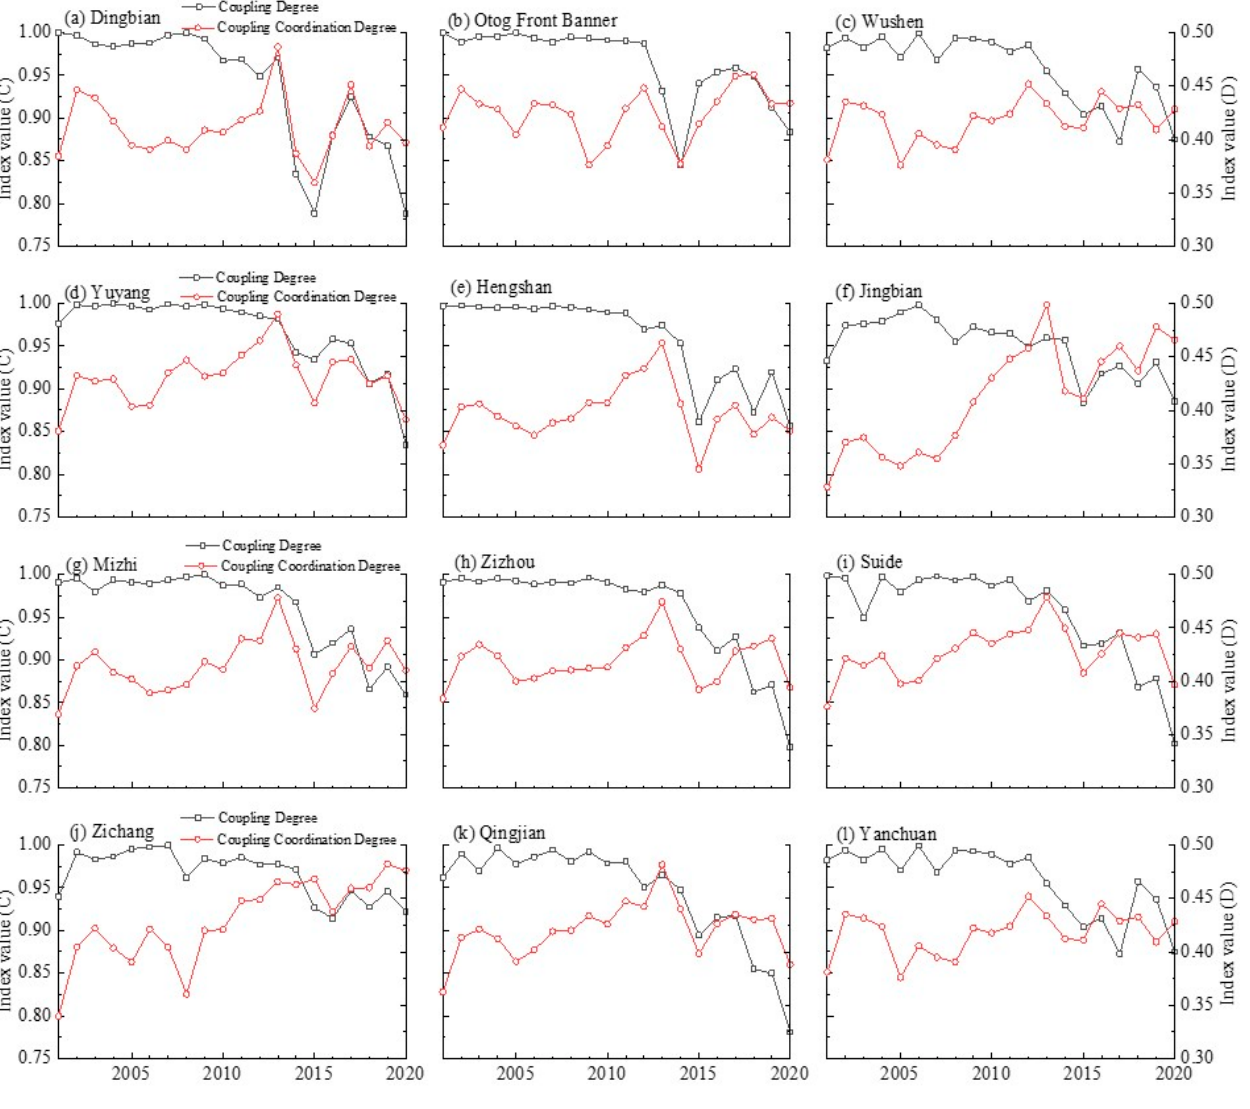
Figure 6. Interannual change trends in the water–ecology–economy coupling degree and coordinated degree, respectively, in ( a – l ) in the Wuding River watershed from 2001 to 2020.